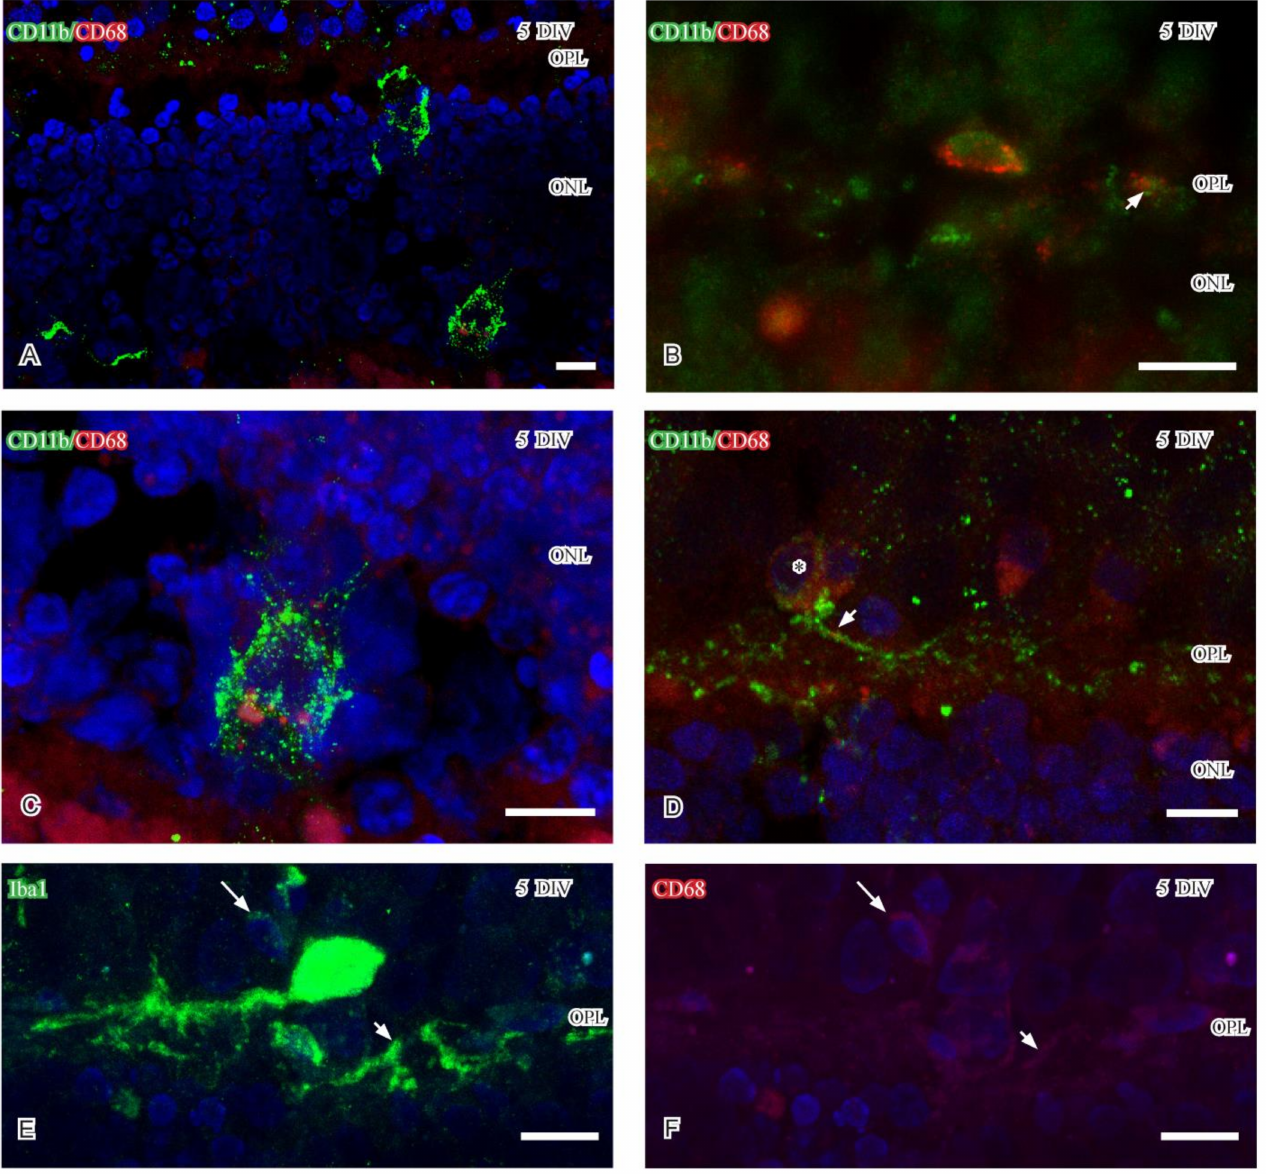
Figure 4. Confocal stacks ( A , C ) and fluorescence micrographs ( B , D ) showing CD68 immunoreactivity (red) and CD11b immunoreactive microglia (green). Confocal stacks ( E , F ) showing CD68 immunore- activity (red) in Iba1 immunoreactive microglia (green). ( A , C ) Vesicular CD 68 immunoreactivity in low and high magnification in the ONL of 5 DIV retina. ( B , D ) Perinuclear CD68 in a CD11b immunoreactive microglia close to the OPL. ( D ) CD68 immunoreactivity in microglial cell body (asterisk) and process (small arrows in B , D ). ( E , F ) CD68 immunoreactivity in large strongly Iba1 immunoreactive microglial cell and processes (small arrows in ( E , F )). Note also small microglia cell body (large arrows in E , F ) displaying weak CD68 and Iba1 immunoreactivities. Abbreviations as in Figure 1. Scale ( A – F ) 10 µ